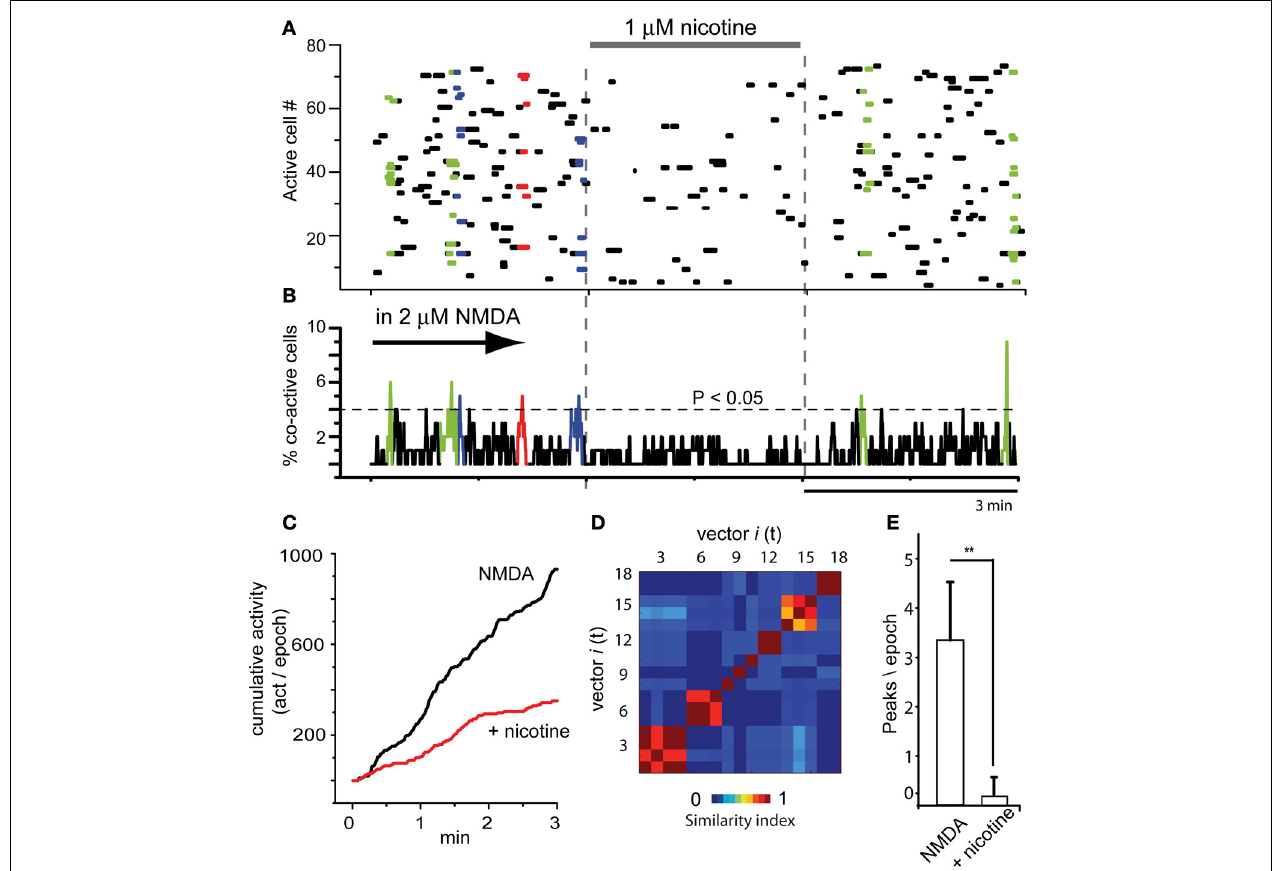
FIGURE 2 | Global actions of nicotine in the striatal circuit are inhibitory. (A) Raster plot illustrating three brief epochs (3min each) taken from larger movies (as in Figure 1A ). Left epoch: the simultaneous activity of 80 neurons in the continuous presence of NMDA (2 μ M; denoted by an arrow, cf., Figure 1 ). The arrow denotes that NMDA is maintained all the time during this experiment. Colored dots show neuronal vectors indicating spontaneous synchronous activity of neuron pools. Middle epoch: nicotine (1 μ M) is added to the bath saline in the presence of NMDA. Note that activity is decreased and the absence of colored dots indicates that spontaneous events of synchronization are now absent. Right epoch: a partial nicotine washing off, two significant peaks of synchronization appear indicating that nicotine